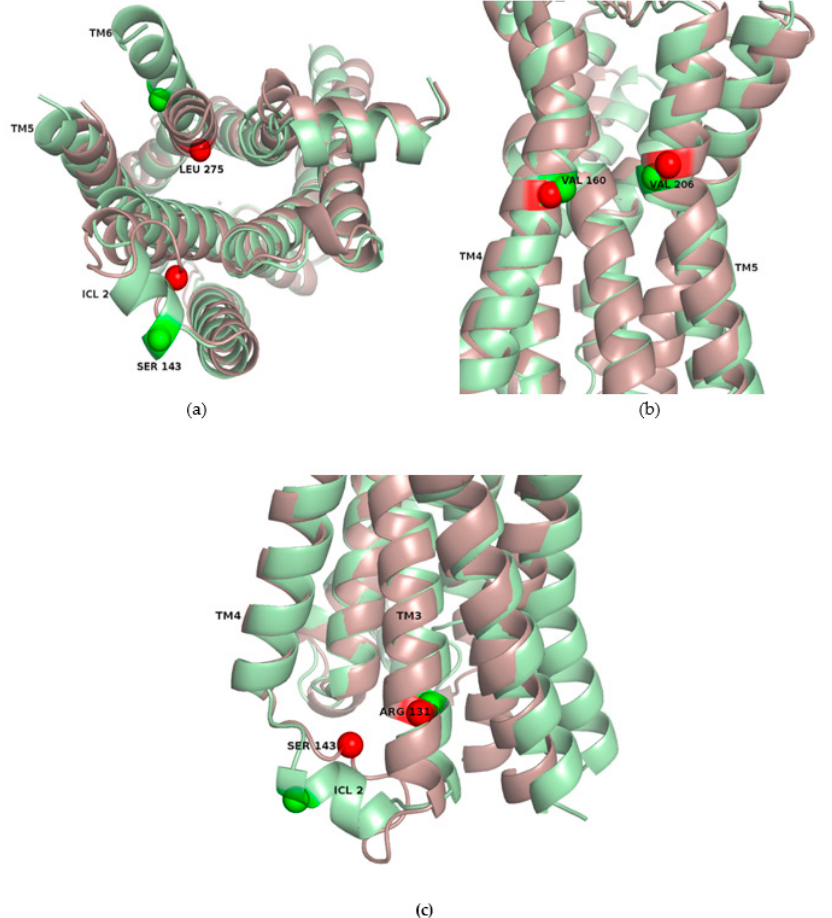
Figure 6. Pairwise distances highly correlated to Δ in β 2AR top-ranked sites. ( a ) L275 and S143, in Site 4; ( b ) V160 and V206, in Site 6; ( c ) S143 and R131, in Site 7. The distances between these residues contribute the most to the coupling strength of the respective sites. The C α′ s of these residues are shown as spheres, and inactive (red) and active (green) conformations are superposed, to highlight the conformational changes of the sites upon receptor activation.